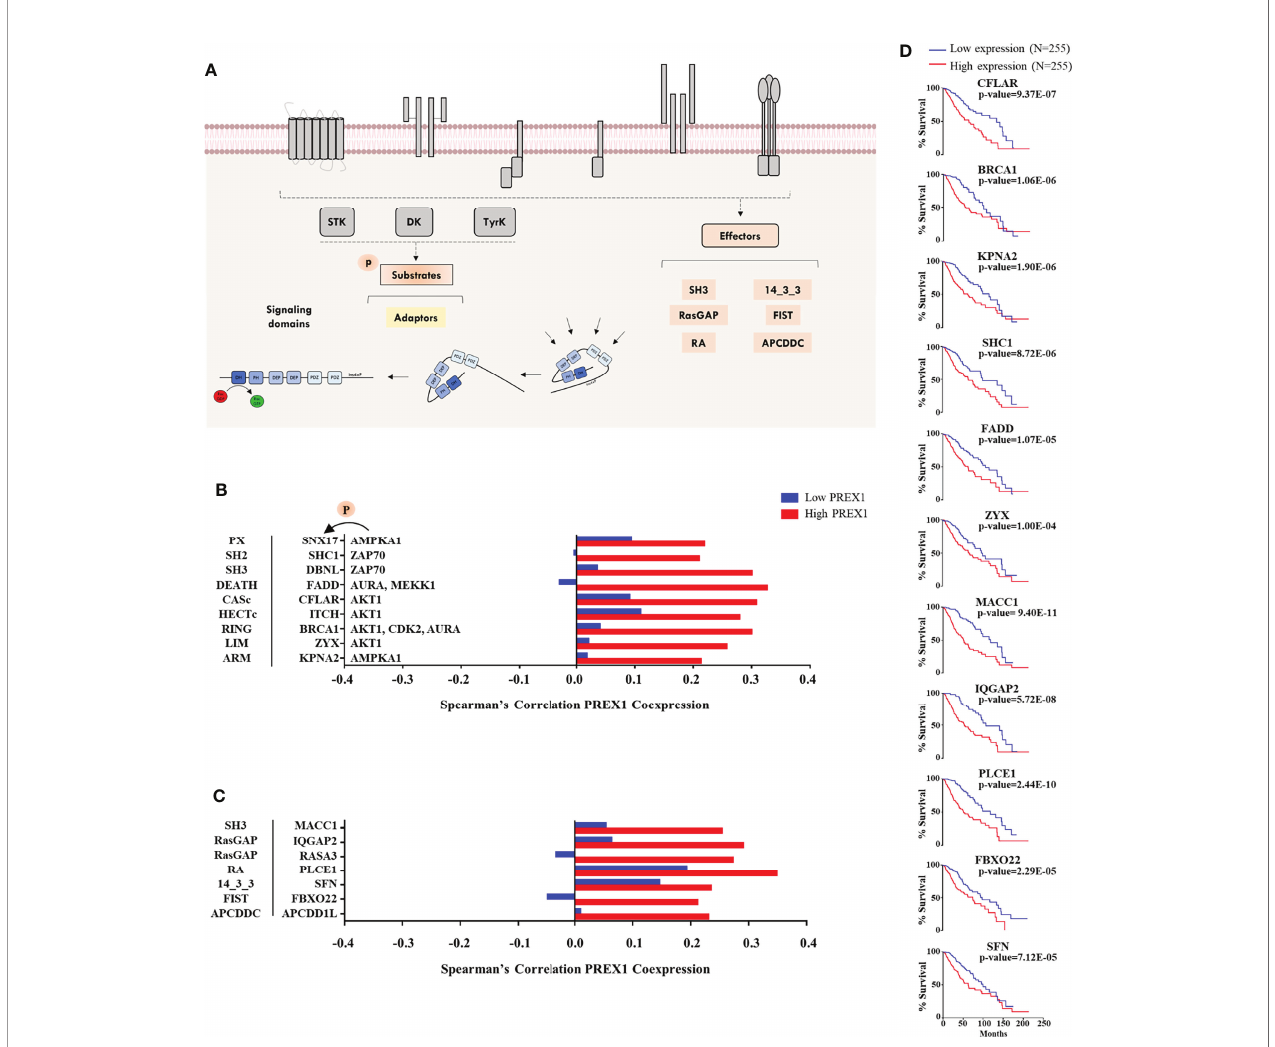
FIGURE 4 | Additional signaling proteins within the repertoire of signaling transcripts highly coexpressed with PREX1 in LGG. (A) Model showing phosphoproteins and effectors potentially linked to P-Rex1 signaling. (B) Transcripts coding for phosphoproteins (identi fi ed as such in the Phosphosite platform) highly coexpressed with PREX1 in the top quartile of the high PREX1 expression group. Their most relevant signaling domains are indicated at the left and their upstream kinases at the right. (C) Diverse signaling proteins and effectors highly coexpressed with PREX1 in the high PREX1 expression set. Their main signaling domains are indicated at the right. Bars represent Spearman ’ s correlation coef fi cients in the low and high PREX1 expression lists (blue and red). (D) Overall survival of LGG patients distributed according to the expression of the indicated transcripts, highly coexpressed with PREX1 , (50:50 percentiles). Statistical signi fi cance was analyzed by the Log-rank